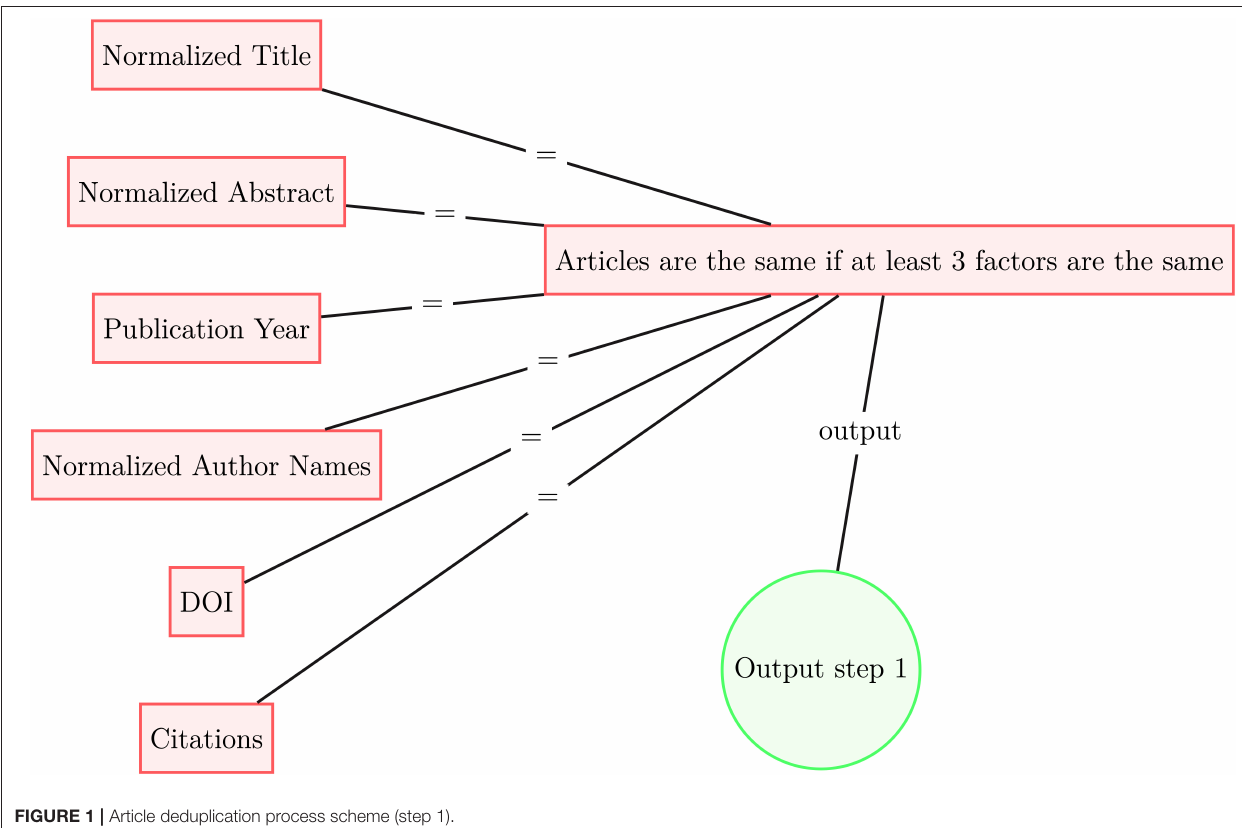
FIGURE 1 | Article deduplication process scheme (step 1).